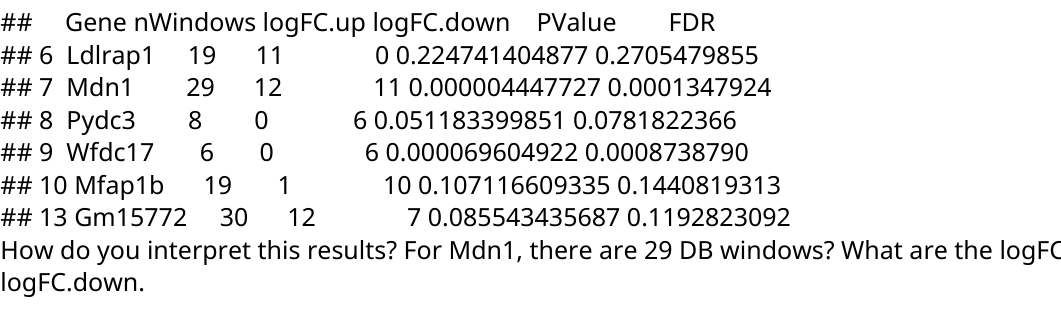
Figure 2 doesn’t make sense. Why is there windows with < 0 abundance? Normalizing for library-specific trended biases. Figure 3 only shows log-fold change between mature B and pro-B but there is more than one sample in mature B and pro-B. How do you apply the normalization? Do you take average of all mature B samples and average of all pro-B samples and then do the loess